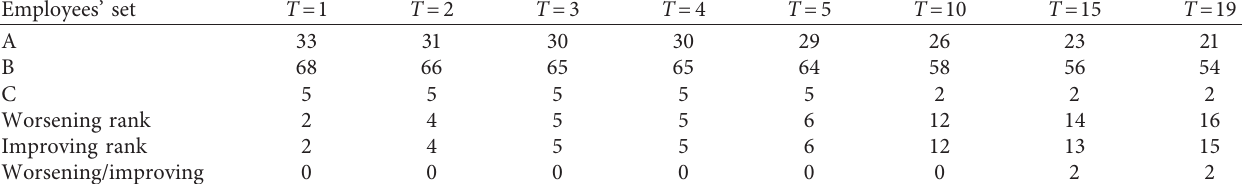
Table 3: Rank story of the employees. Number of employees who changed or did not change their rank during the twenty years simulation. Employees’ set